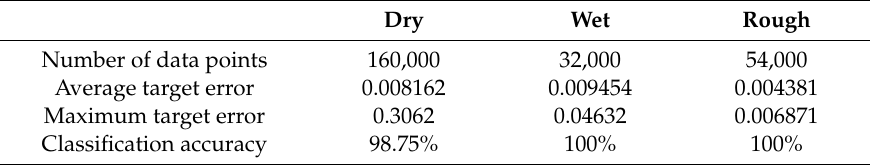
Table 2. Number of acceleration data points measured while driving in the